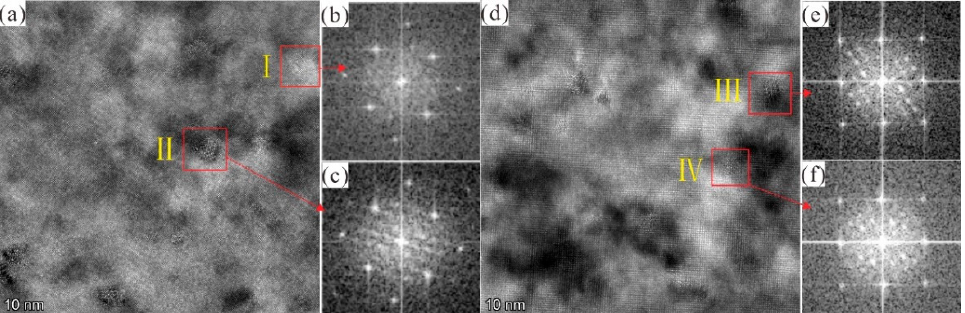
Figure 4. Representative high-resolution image of the primary strengthening phase in the Al–Mg– Si alloy. ( a ) Overviews of the precipitated particles in the samples under the 180 °C peak-aged condition. ( b , c ) corresponding FFT patterns of the GP zone and β ” precipitates corresponding to zone I and zone II in ( a ), respectively. ( d ) Overviews of the precipitated particles in the samples under the 180 °C overaged condition. ( e , f ) Corresponding FFT patterns of the β ” and β ’ precipitates corresponding to zone III and zone IV in ( d ), respectively.